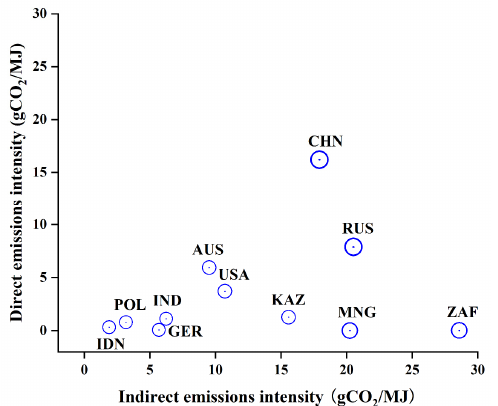
Figure 3. Coal-producing countries’ CO 2 emission intensity distribution. 3.2. Indirect CO 2 Emission Intensity of Coal Production from Material and Service Inputs Compared to the bottom-up approach, the top-down input–output method can